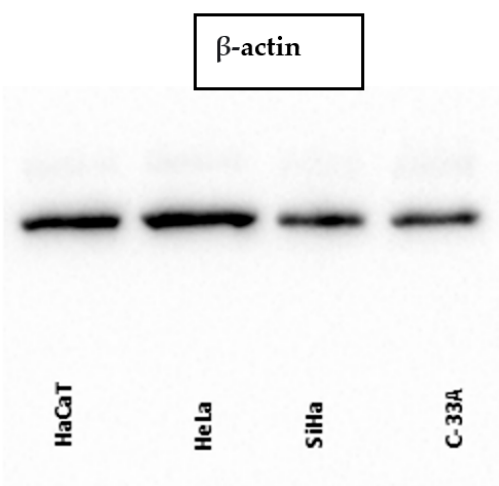
Figure 3. WB: testin expression in HaCat, HeLa, SiHa and C-33 A cell lines.